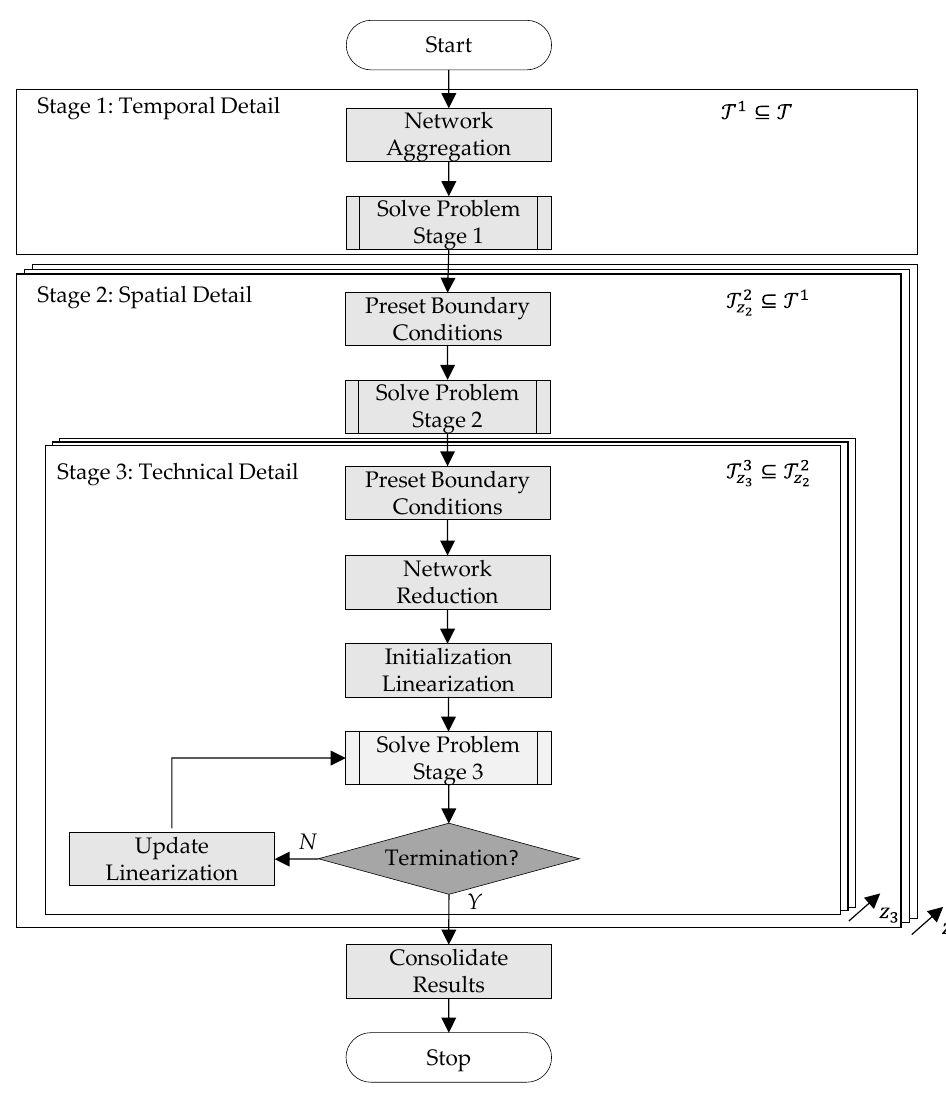
Figure 2. Flowchart of the nested decomposition approach.